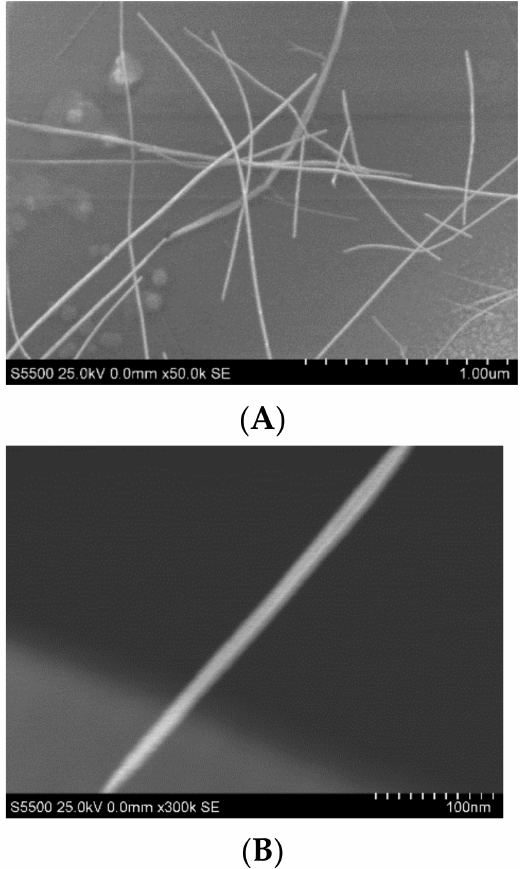
Figure 1. SEM images of the water dispersion of single-wall carbon nanotubes (SWCNTs) stabilized by carboxymethylcellulose at higher ( A ) and lower ( B )